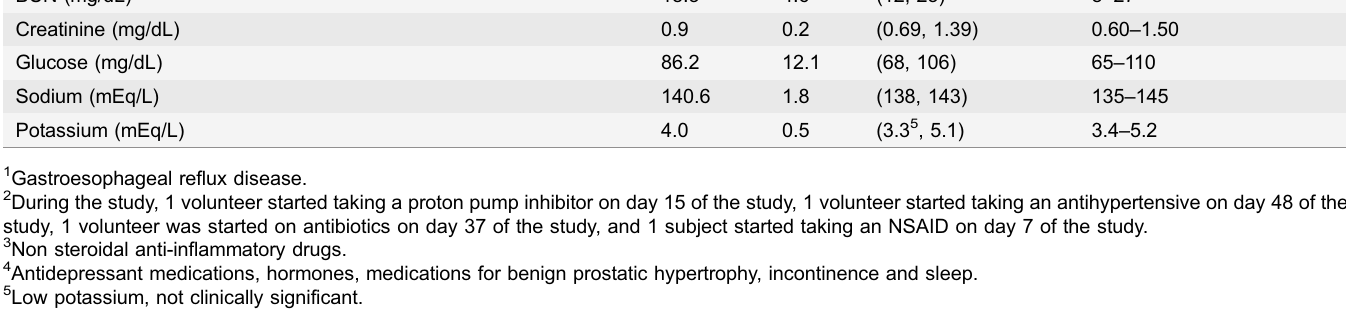
2 prior cholecystectomies, 1 prior kidney surgery, and 4 prior thoracic surgeries. A total of 4 volunteers started 5 medications during the study period – proton